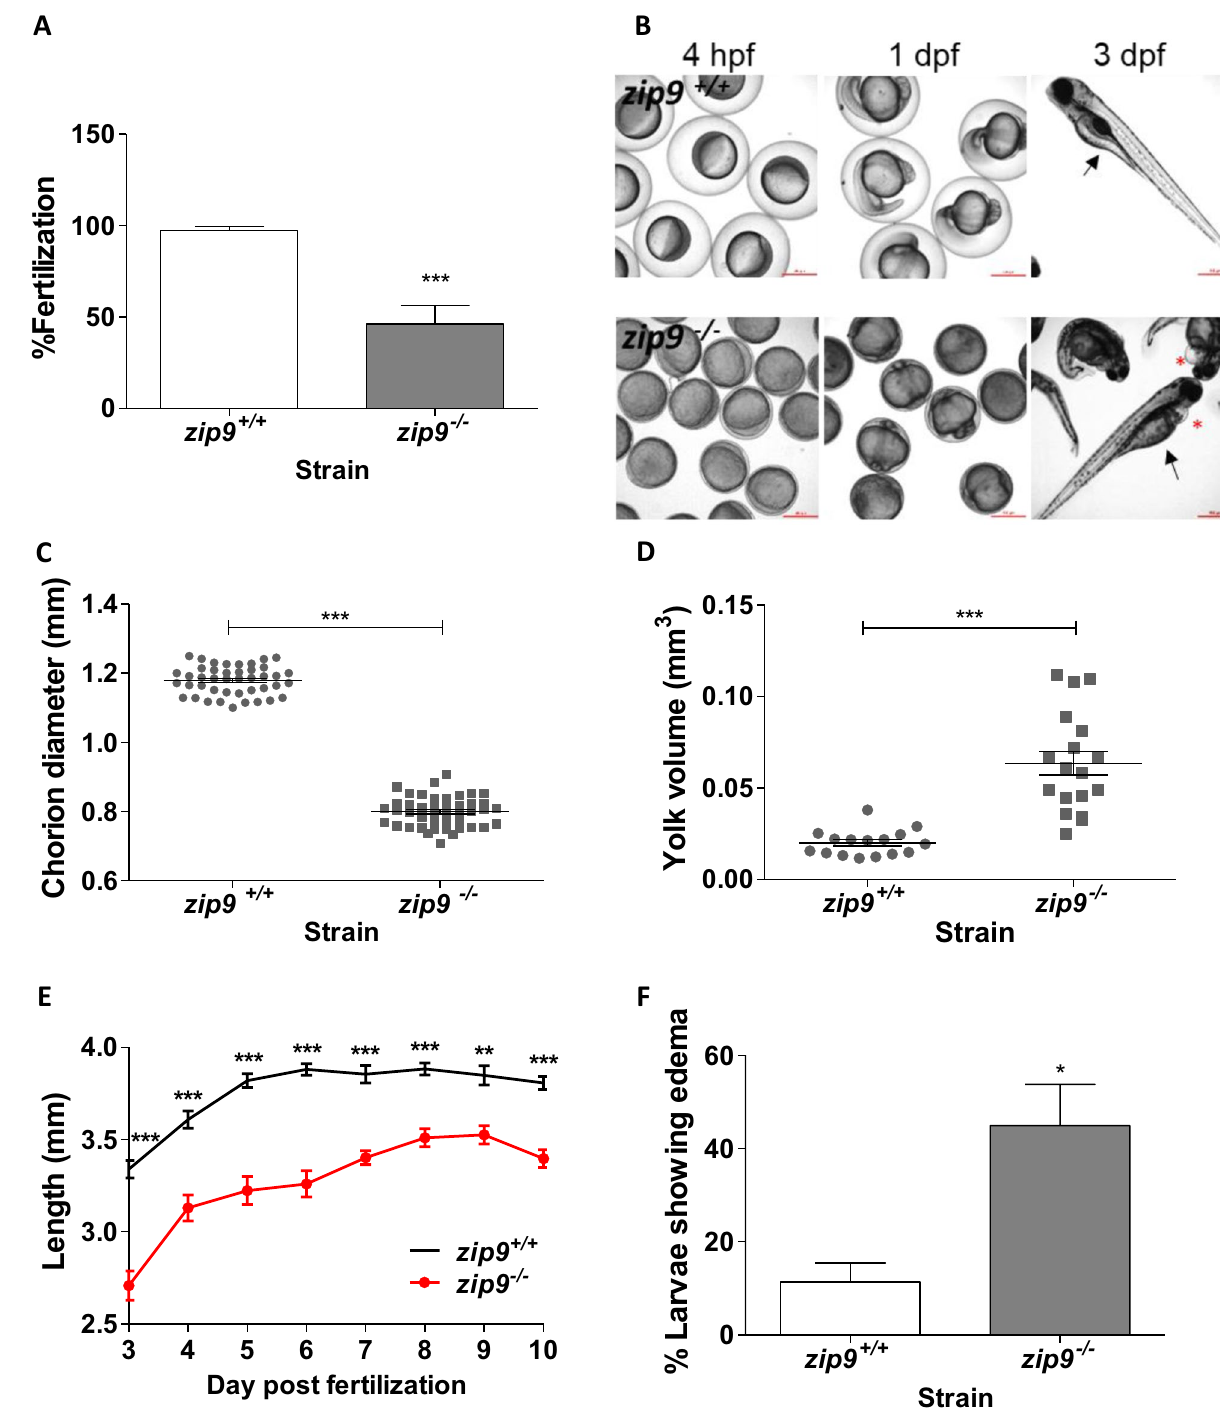
Figure 2. Characterization of zip9 -mutant phenotype. (A) Percent of viable eggs ovulated by zip9 -/- and zip9 + / + females 2 h post fertilization (hpf); n = 13–14 clutches. (B) Representative image of zip9 + / + and zip9 -/- embryos at 4 hpf and 1 and 3 days post fertilization (dpf). Scale bars: 500 µm. Arrows donate the yolk sac in WT and mutants (3 dpf) and asterisks donate edema in zip9 -/- larvae (3 dpf). (C) Chorion diameter of eggs spawned by zip9 -/- and zip9 +/+ females; n = 40. (D) Yolk volume of 3 dpf zip9 -/- and zip9 +/+ larvae; n = 16–18. (E) Length of zip9 -/- and zip9 +/+ larvae without exogenous feeding between 3–10 dpf; n = 10–21. (F) Incidence of pericardial/ yolk sac edema in 6 dpf zip9 -/- and zip9 +/+ larvae; n = 5 clutches. All data represents means ± SEM. Significance was determined by Welch’s t -test (*, P < 0.05; **, P < 0.001; ***, P <